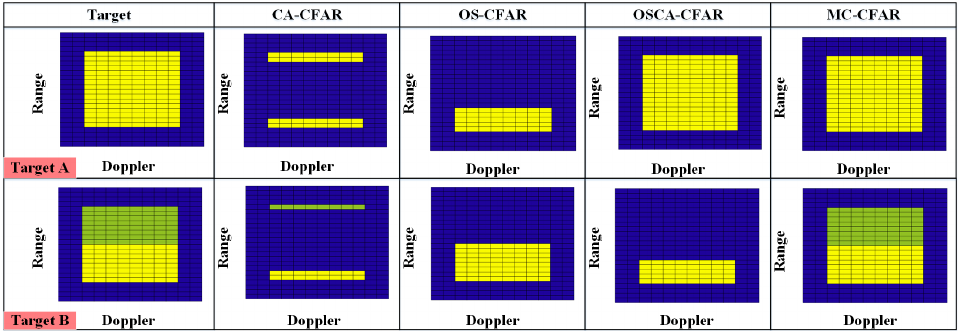
Figure 16. CFAR detection